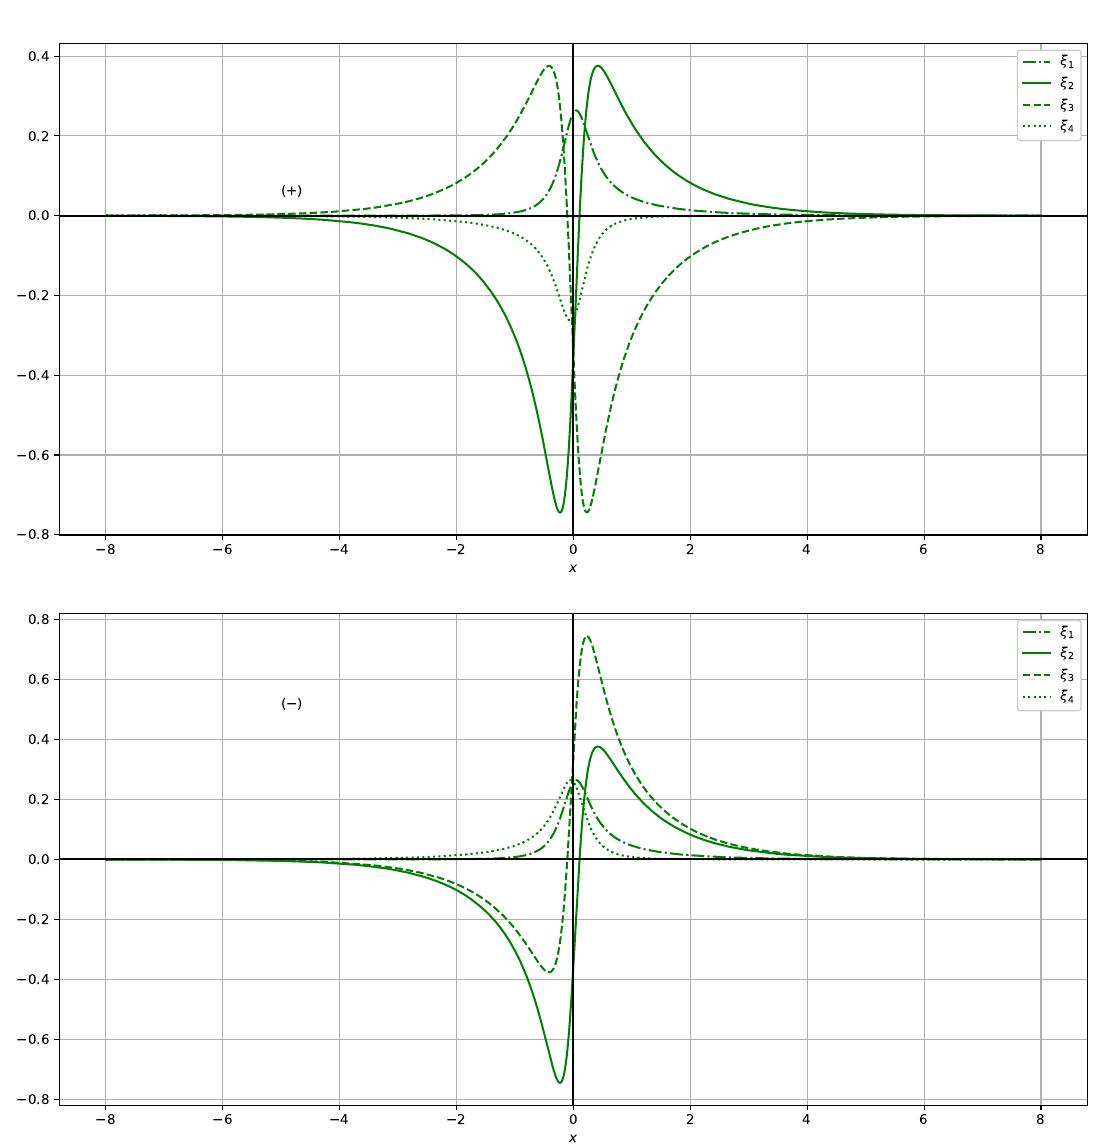
Figure 20 . Numerically simulated bound state components as functions of x for positive parity σ = +1 (Top figure) and negative parity σ = − 1 (Bottom figure). They are hosted by the kink with θ 0 = 2 . 5 (green kink in the figure